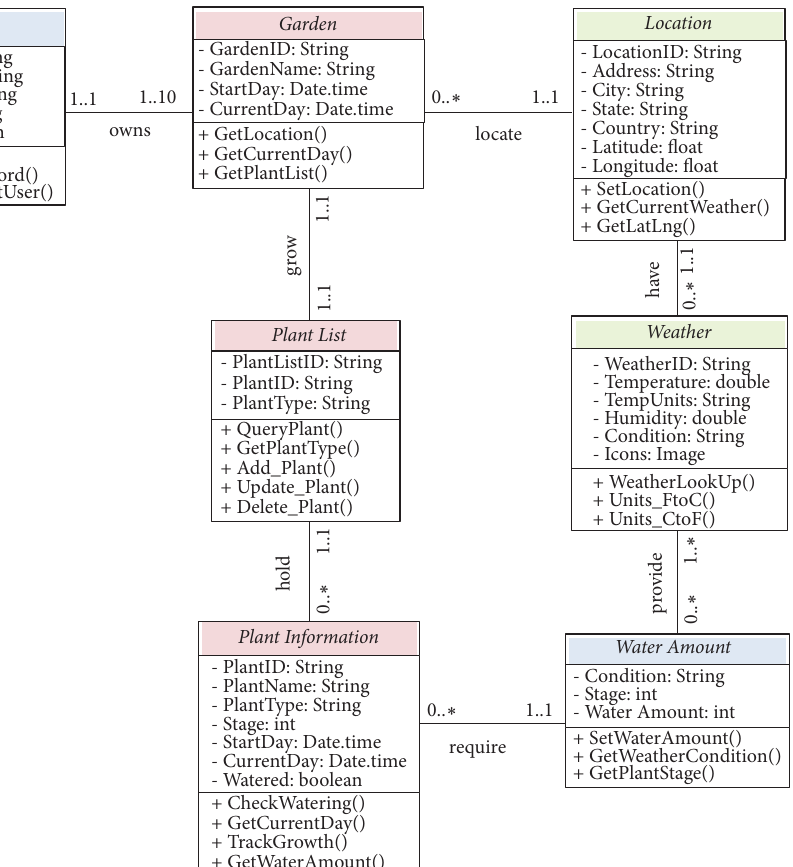
Figure 6: Database schema of Little